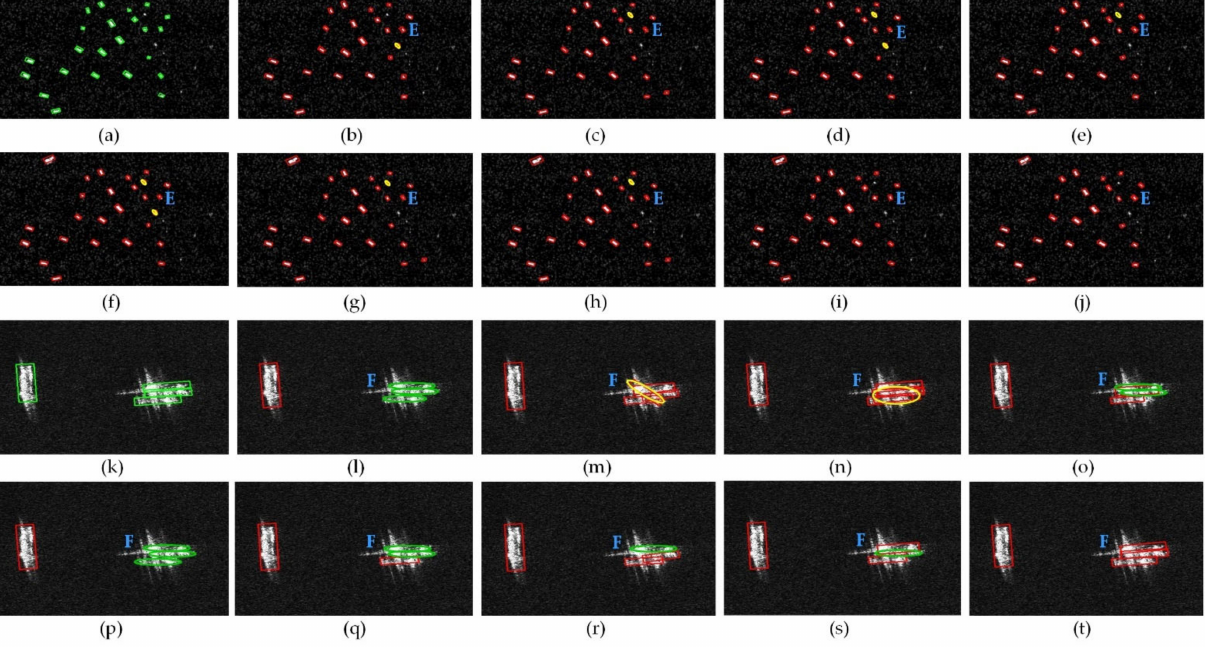
Figure 14. Detection results of different methods in offshore scene. ( a , k ) ground-truths. ( b , l ) results of YOLOv5s-CSL. ( c , m ) results of YOLOv5m-CSL. ( d , n ) results of YOLOv5l-CSL. ( e , o ) results of YOLOv5x-CSL. ( f , p ) results of YOLOv5s-DCL. ( g , q ) results of YOLOv5m-DCL. ( h , r ) results of YOLOv5l-DCL. ( i , s ) results of YOLOv5x-DCL. ( j , t ) results of BiFA-YOLO. Note that the red boxes represent true positive targets, the yellow ellipses represent false positive targets and the green ellipses represent missed